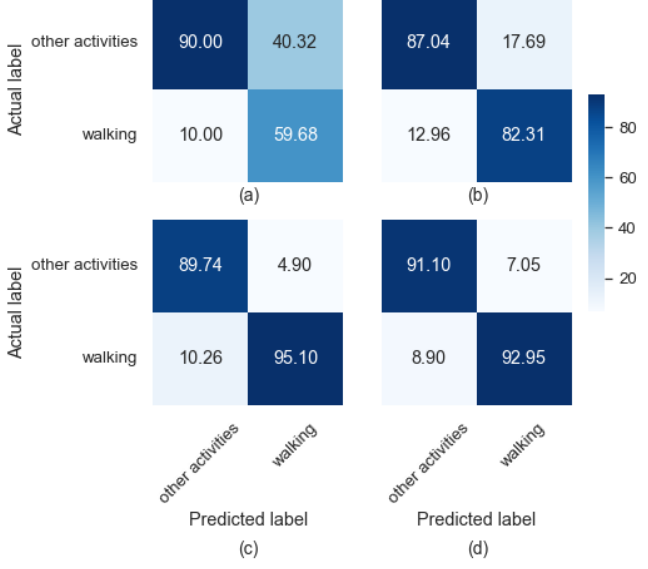
Figure 7. Confusion matrix of: ( a ) kNN, ( b ) RF, ( c ) XGB, and ( d ) Stack for S = 5 s. The numbers are in percentage. The color bar shows the actual number of segments that fall into different cells of the